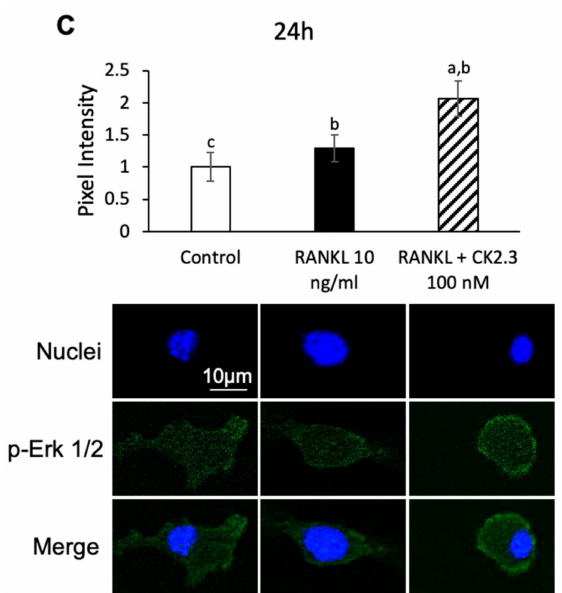
Figure 6. E ff ect of CK2.3 on p-Erk 1 / 2 in RANKL-induced osteoclastogenesis. CK2.3 increased p-Erk 1 / 2 after 24 h of stimulation in RAW264.7 cells, as determined by ( A ) Western blotting and ( B ) immunofluorescence. p-Erk 1 / 2 was increased after 24 h of stimulation, as determined by immunofluorescence in ( C ) primary osteoclast precursors of 6-month-old B6 mice. a: denotes significant di ff erence from Control, b: denotes significant di ff erence from RANKL at 10 ng / mL, and c: denotes significant di ff erence from RANKL + CK2.3 at 100